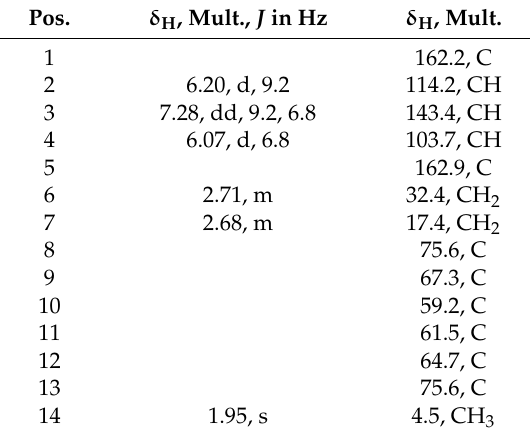
Table 1. 1 H and 13 C NMR data of Echinophorin D ( 3 ) a .